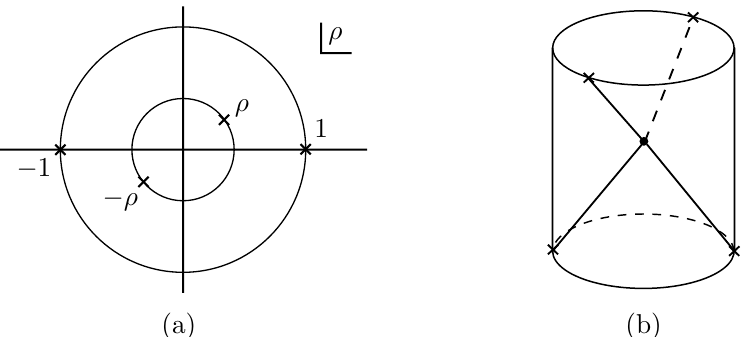
Figure 5 . (a) Four-point kinematics in the complex (cid:26) -plane. (b) The kinematics on the Lorentzian cylinder. In the \bulk-point" limit z ! (cid:22) z , particles are e(cid:11)ectively beamed onto a point in the AdS interior of the